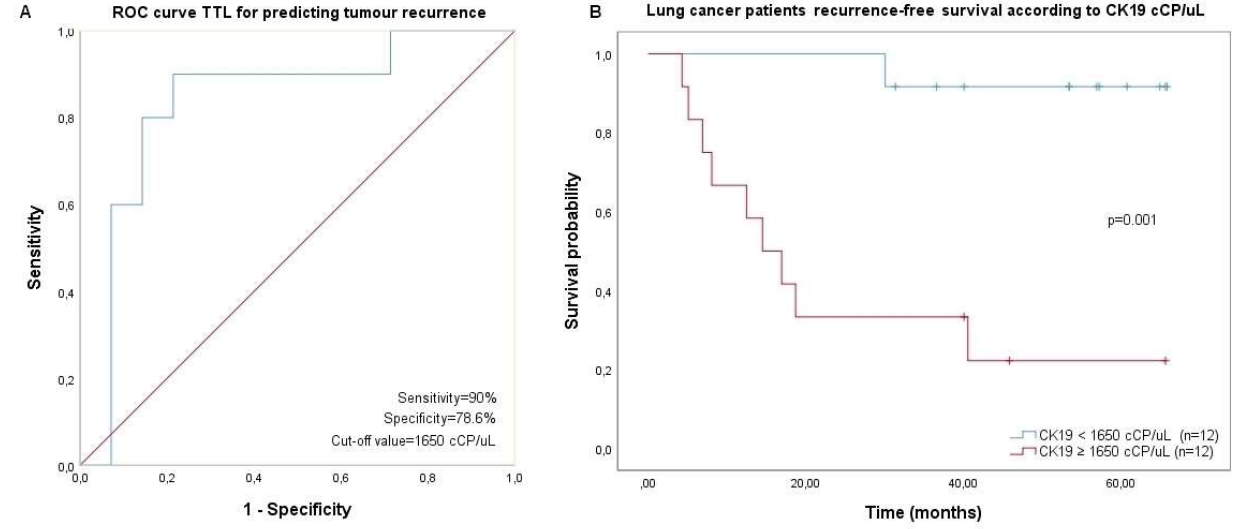
Figure 4. ROC curve for recurrence. Area = 0.836 95% IC (0.659–1.000), p -value = 0.006 ( A ). OS curve for patients without recurrence (<1650 cCP/uL) vs. patients with recurrence, p -value = 0.001 ( B ).